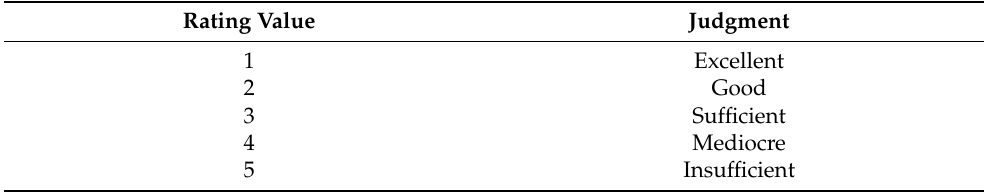
Table 3. Rating scale of